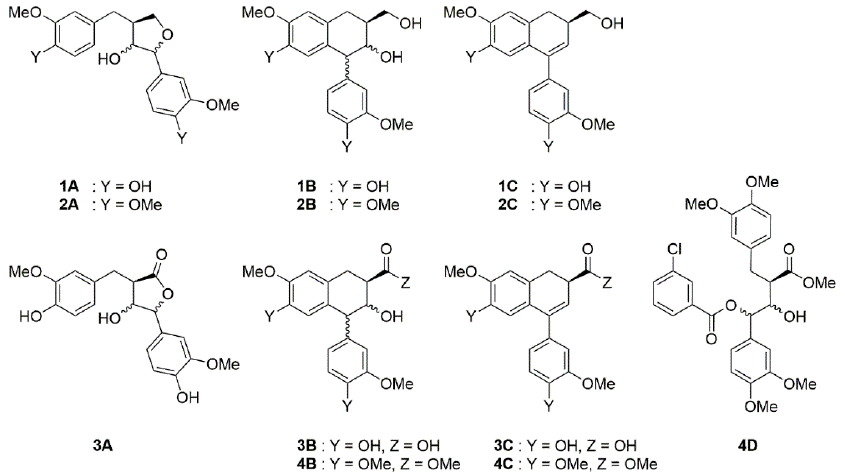
Figure 3. Products formed in the reactions.